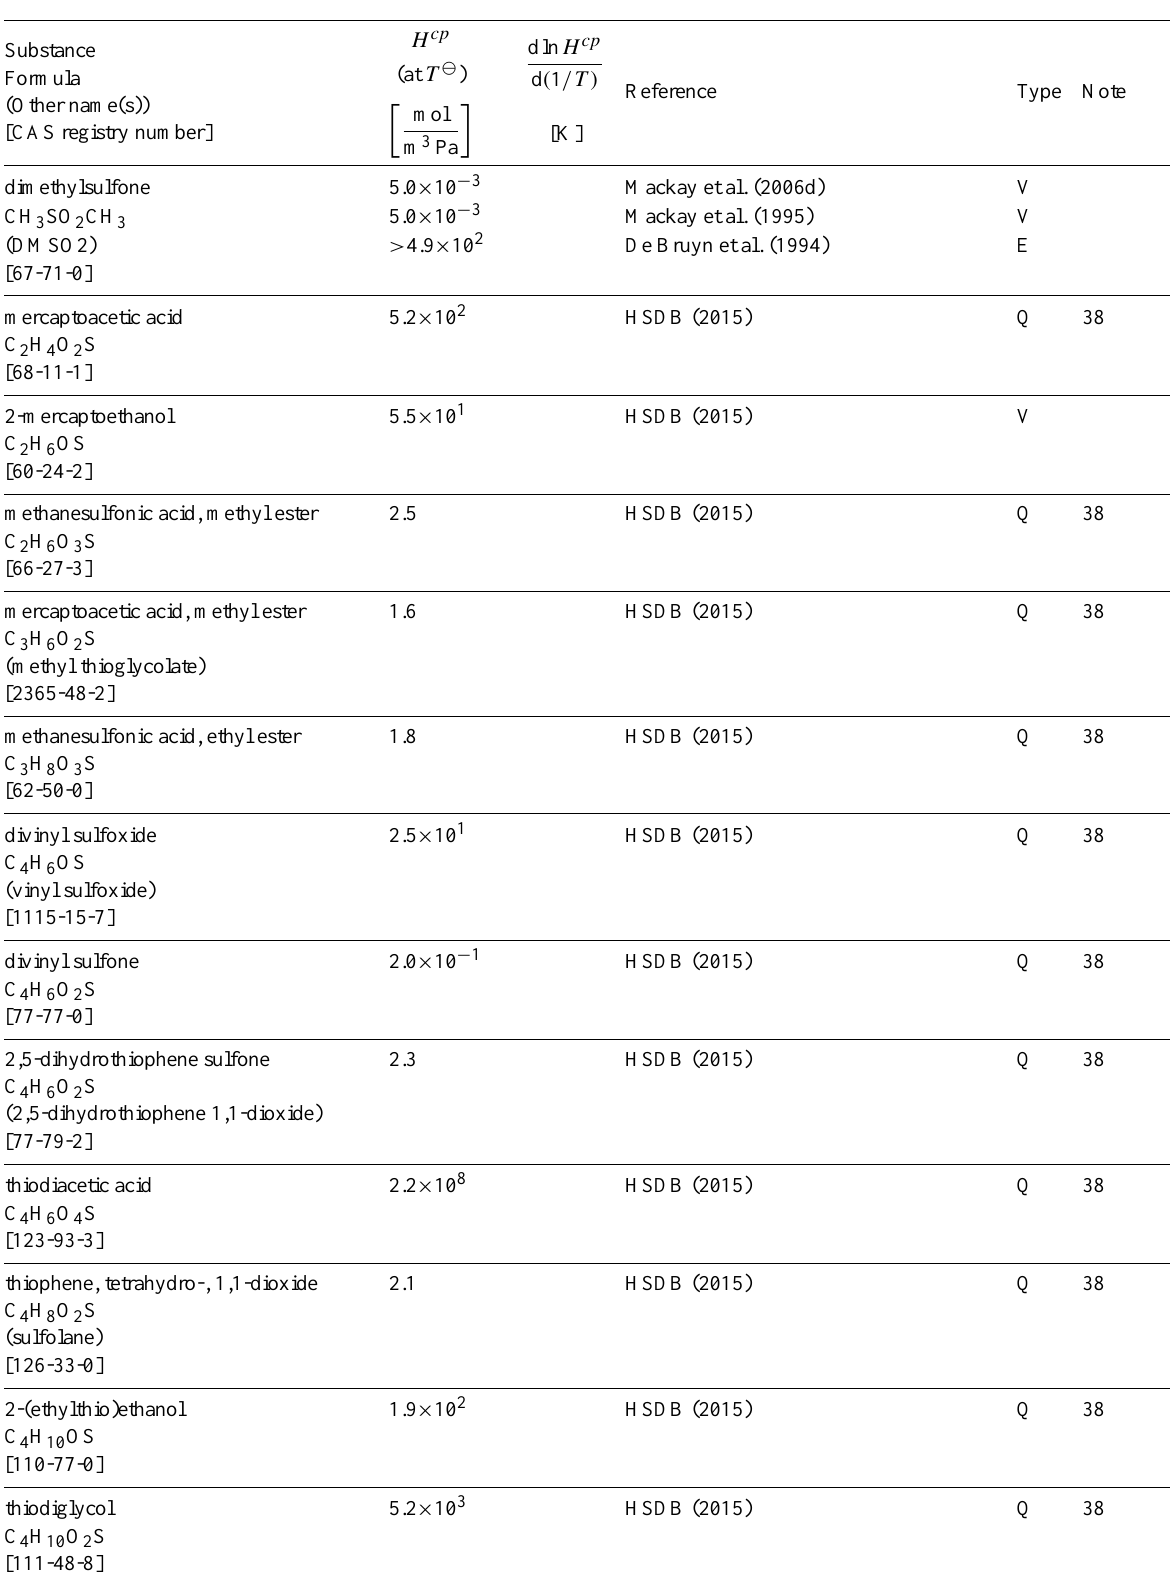
Table 6: Henry’s law constants for water as solvent